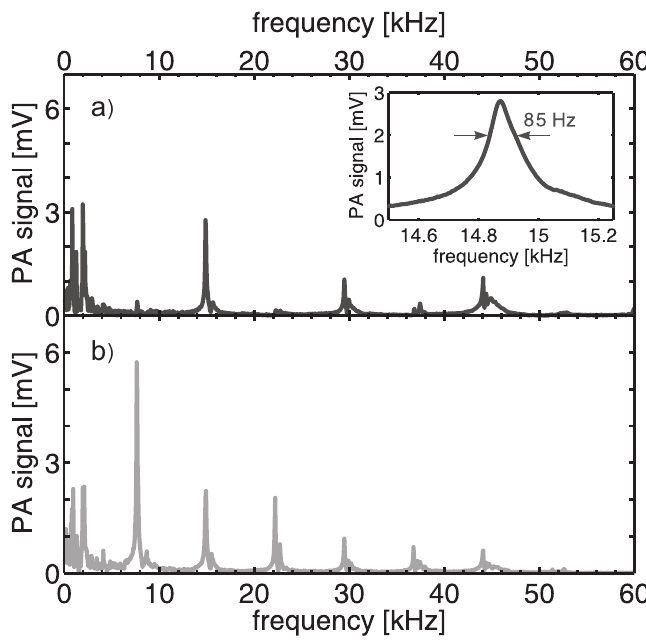
Figure 3. Acoustic resonances of the planar MPAC with the plane of multipassed laser beams lying horizontally (a) in the center and (b) at the bottom of the cell. The longitudinal resonances occur above 7.86 kHz. The 2nd longitudinal resonance at 14.87 kHz, having a Q value of 175, is shown in the inset. Only even longitudinal modes are excited when the laser beams are located in the center of PA